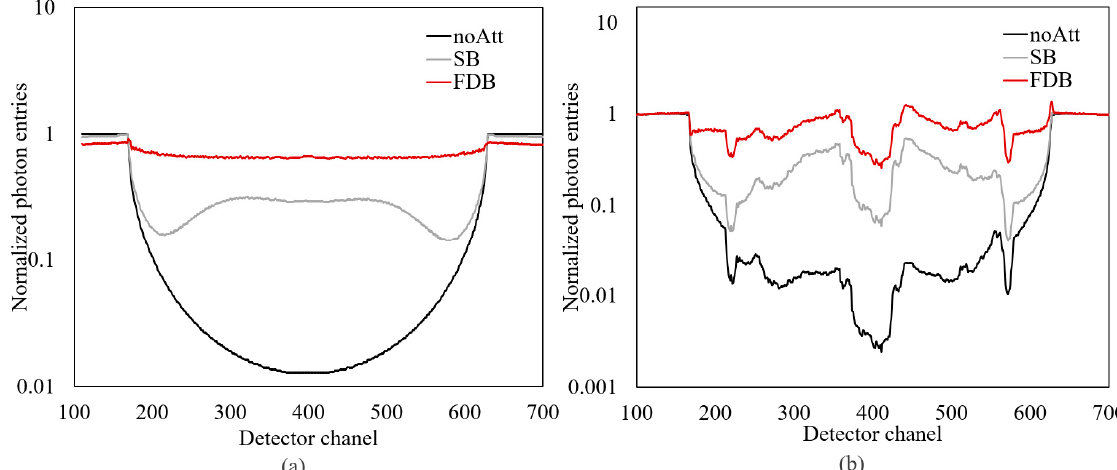
Figure 3. Normalized photon counts reaching the detector panel along the AP direction using different bowties for scanning ( a ) body-equivalent water phantom and ( b ) an adult abdomen.